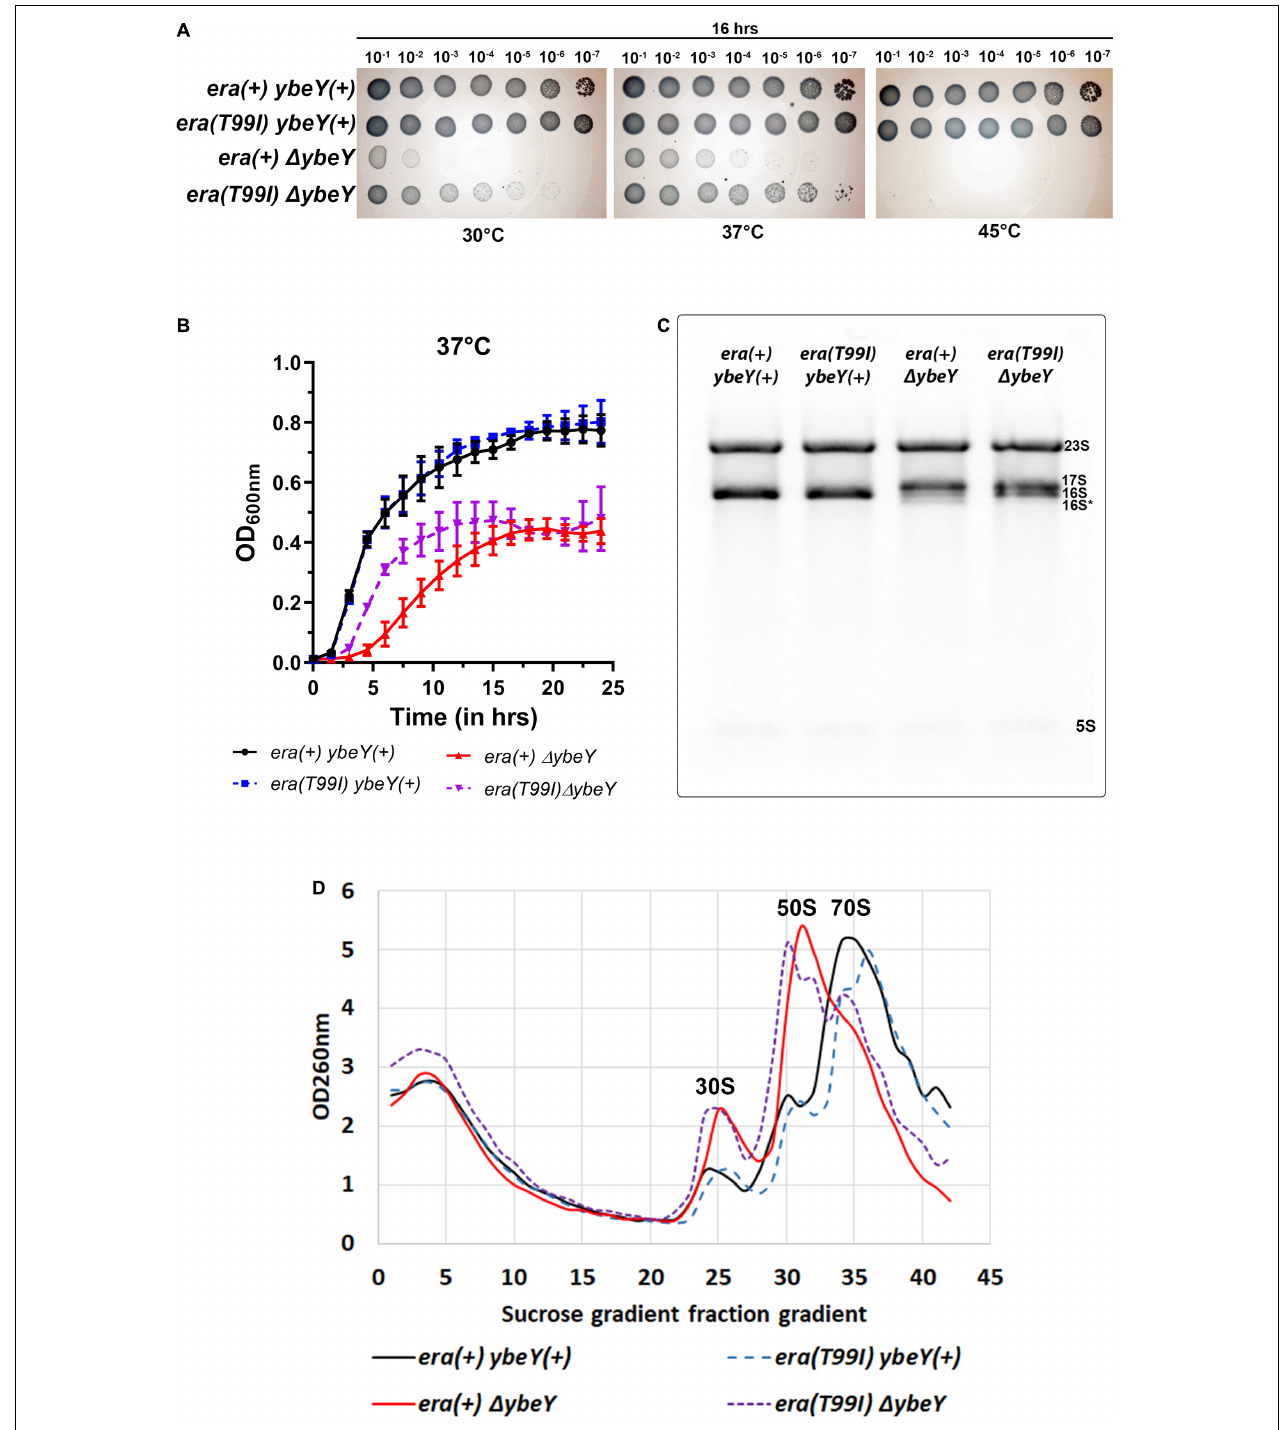
FIGURE 3 | The era(T99I) mutation improves the growth defect of a (cid:49) ybeY . (A) Tenfold serial dilutions of the overnight cultures were spotted onto LB agar plates and incubated at the indicated temperatures for 16 h. Representative sections of the imaged plates are shown. (B) Growth curves of strains era( +) ybeY( +) (black, continuous line, circles), era(T99I) ybeY( +) (blue, broken line, squares), era( +) (cid:49) ybeY (red, continuous line, triangles), and era(T99I) (cid:49) ybeY (purple, broken line, inverted triangles) determined in liquid LB media at 37 ◦ C by measuring OD at 600 nm in a plate reader for 24 h. The average ± SD of three determinations is shown. (C) Equal amounts of total RNA samples were separated on a Synergel-agarose gel by electrophoresis. A representative gel image of at least three independent determinations is shown. (D) Total cell lysate of the strains era( +) ybeY( +) (black, continuous line), era(T99I) ybeY( +) (blue, broken line), era( +) (cid:49) ybeY (red, continuous line), and era(T99I) (cid:49) ybeY (purple, broken line) separated by sucrose gradients and the amount of RNA was determined by measuring absorbance at 260 nm.